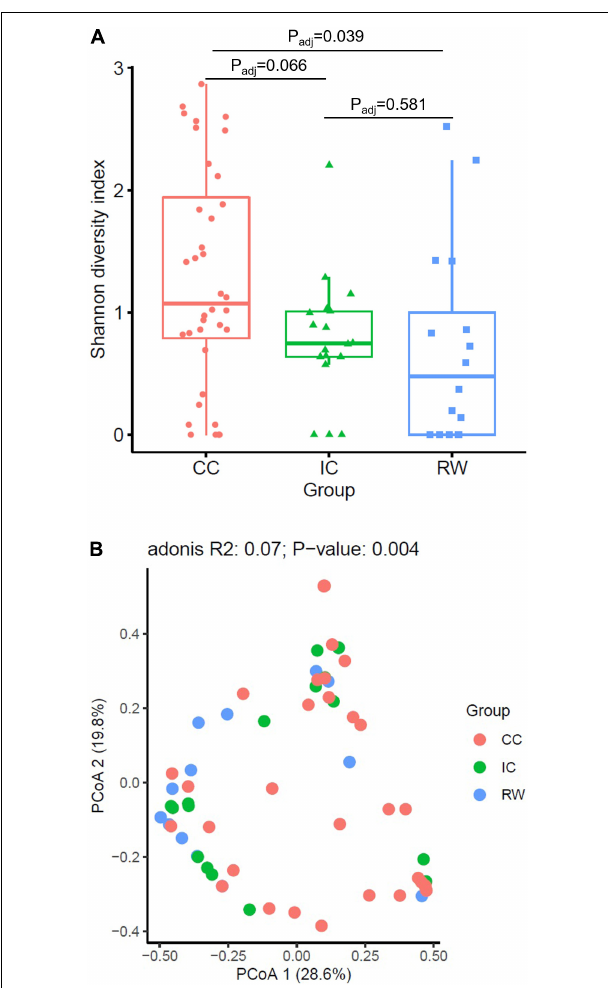
FIGURE 1 | Alpha and beta diversity of NPM in subjects from three clinical groups. (A) Boxplots of Shannon diversity index among RW ( n = 16), IC ( n = 18) and CC ( n = 36) groups. (B) Principal coordinate analysis (PCoA) plot based on Bray–Curtis dissimilarity. PERMANOVA test were performed by adjusting for age and HRV status. Points refer to samples that were color coded by each group. CC, community control; IC, inpatient control; RW, recurrent